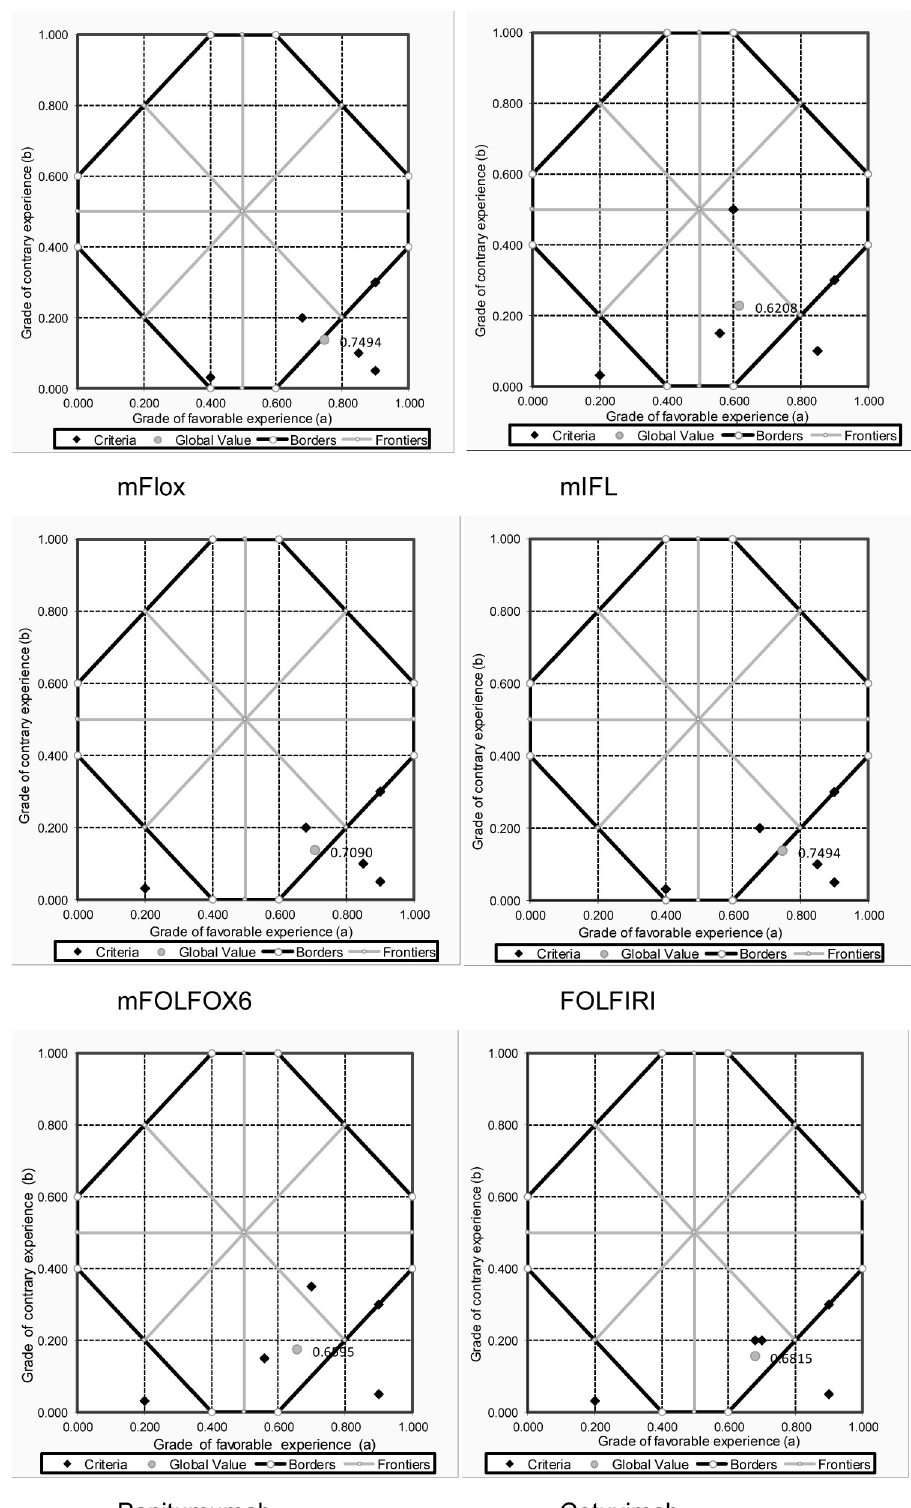
Fig 3. Paraconsistent analysis of first line metastatic colorectal cancer treatments. 1 = modified Flox (5FU, oxaliplatin, leucovorin); 2 = modified IFL (irinotecan, 5FU, leucovorin); 3 = modified FOLFOX6 (5FU, oxaliplatin, leucovorin); 4 = FOLFIRI (5FU, oxaliplatin, irinotecan, leucovorin); 5 = Panitumumab; 6 = Cetuximab. https://doi.org/10.1371/journal.pone.0268584.g003 PLOS ONE | https://doi.org/10.1371/journal.pone.0268584 May 25,